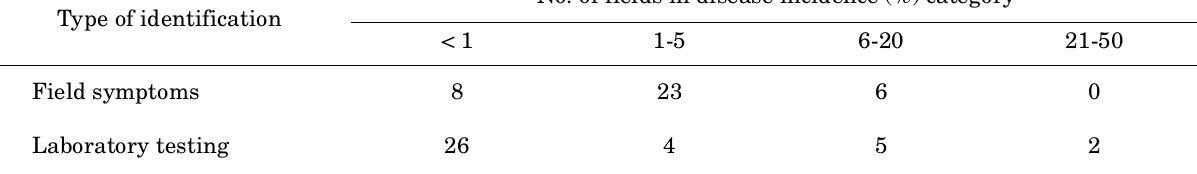
Table 4. Comparison between virus incidence in 37 faba bean fields as determined by visual inspection in the field and as determined by laboratory (serological) testing of randomly collected samples from the Shewa and Arsi re- gions, in